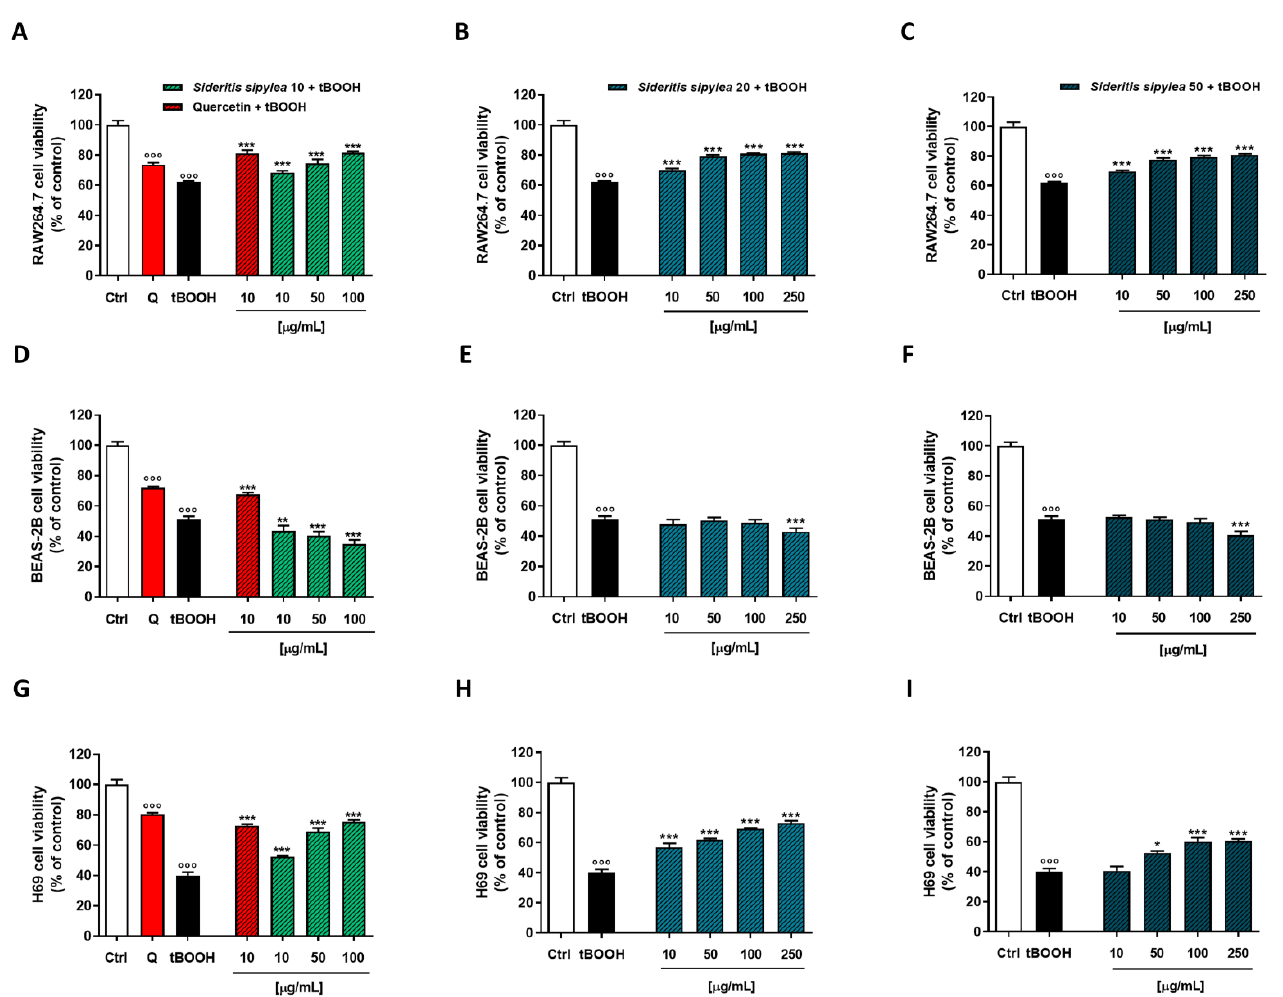
Figure 5. Cytoprotective activity of the positive control quercetin (Q) and of S10, S20, and S50 fractions from Sideritis sipylea Boiss towards the tBOOH-induced oxidative damage in nonmalignant mouse macrophages RAW264.7 ( A – C ), human bronchial epithelium BEAS-2B cells ( D – F ), and human intrahepatic cholangiocytes H69 ( G – I ) determined by MTT assay. Data displayed as mean ± SE of at least three technical replicates from two experiments ( n = 3). ◦◦◦ p < 0.001 vs. control (Student’s t -test); * p < 0.05, ** p < 0.01, and *** p < 0.001 vs. tBOOH (one-way ANOVA followed by Dunnett’s multiple comparison post-test).